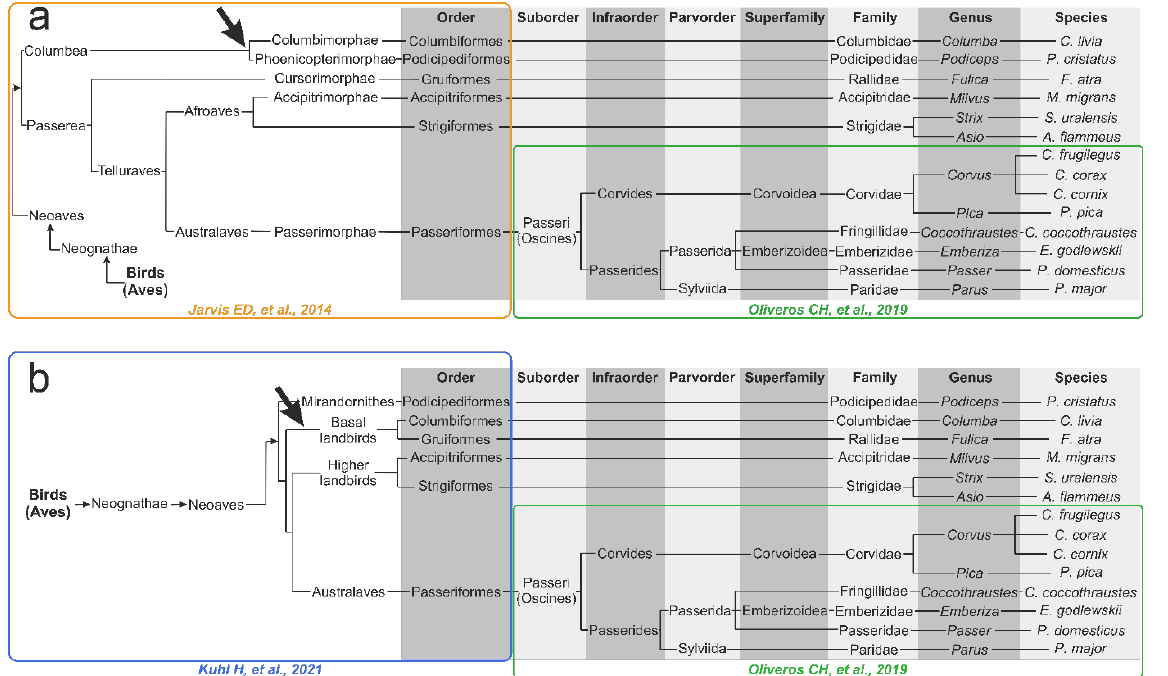
Figure 4. Schematic representation of phylogenetic dendrograms, manually reconstructed from the literature: ( a ) Backbone part of a tree from the class to the orders based on the work of Jarvis ED et al. [24] (yellow rectangle); ( b ) Backbone part of a tree from the class to the orders based on the work of Kuhl H et al. [27] (blue rectangle). The Passeriformes part was adapted from the work of Oliveros CH et al. [42] (green rectangles). The arrow indicates the main difference between the 2 trees related to the 14 bird species under